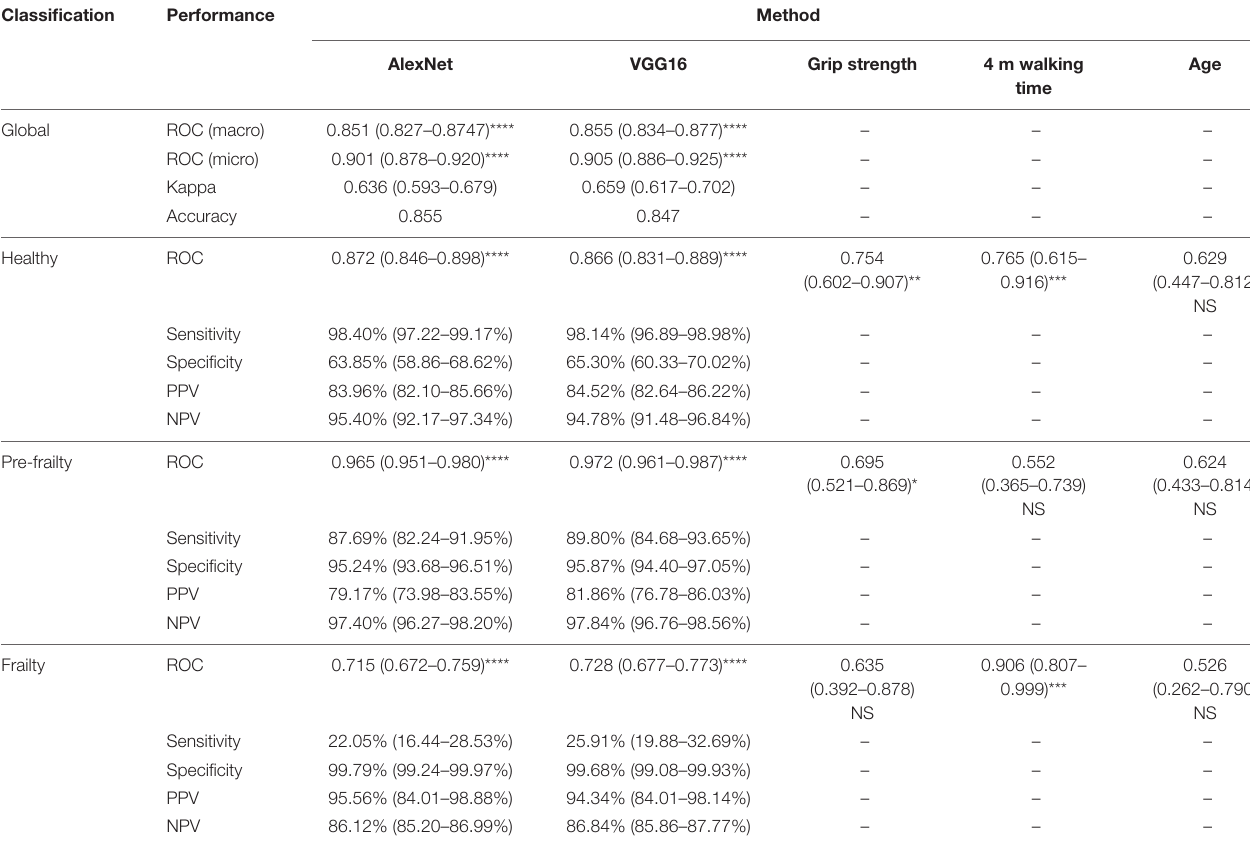
TABLE 2 | Predictive performance of physical frailty state classification via different method.